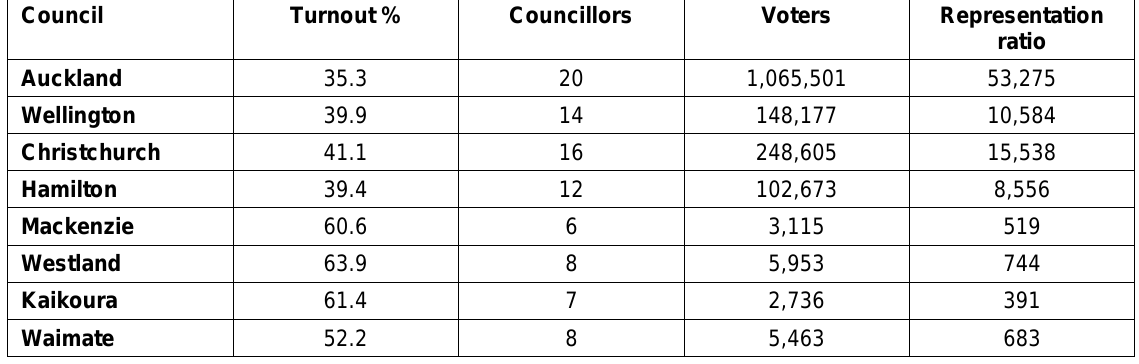
Table 4: Turnout and councillor/voter representation ratios for large and small councils, 2019